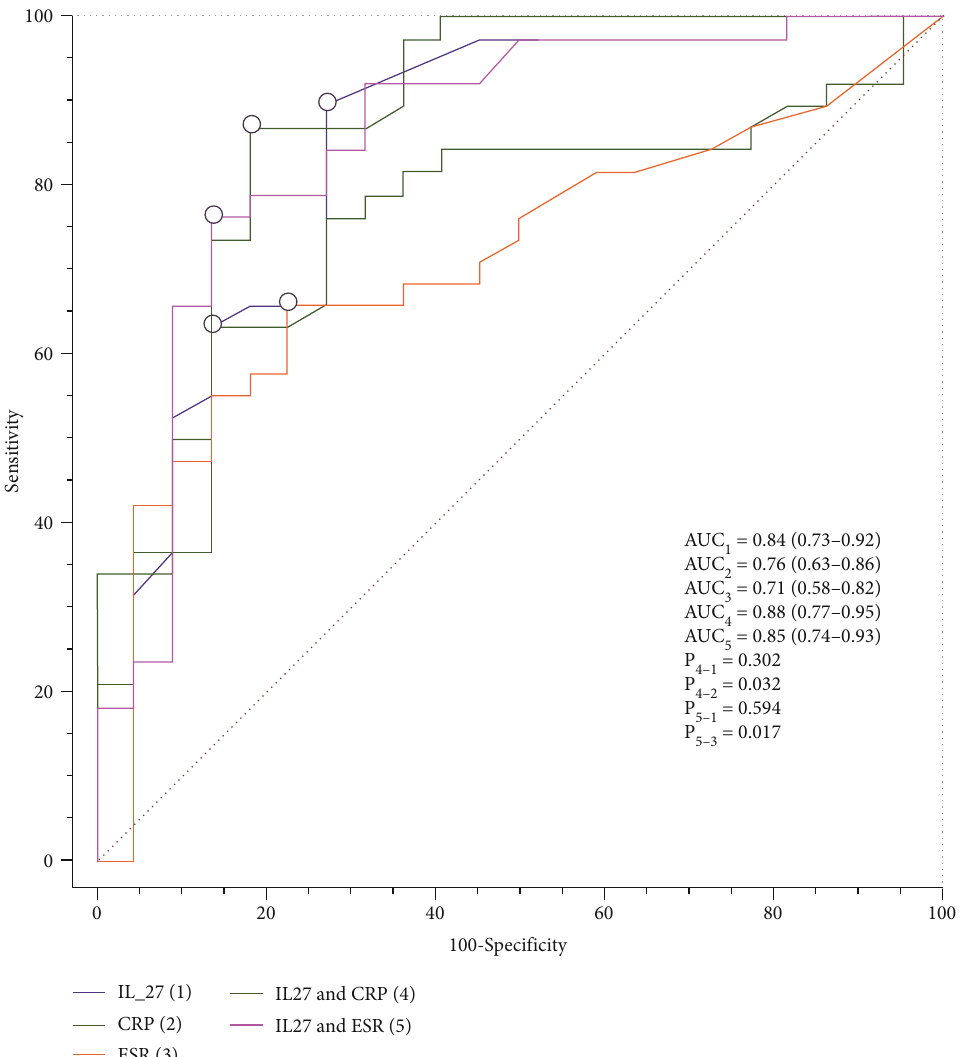
Figure 4: Discriminatory power of IL-27, CRP, ESR, IL-27+CRP, and IL-27+ESR for the disease activity of CD patients by using receiver operating characteristic (ROC) curves. Areas under the ROC curves (AUCs) were analyzed by using the Z -statistic. CRP: C-reactive protein; ESR: erythrocyte sedimentation rate; CD: Crohn ’ s